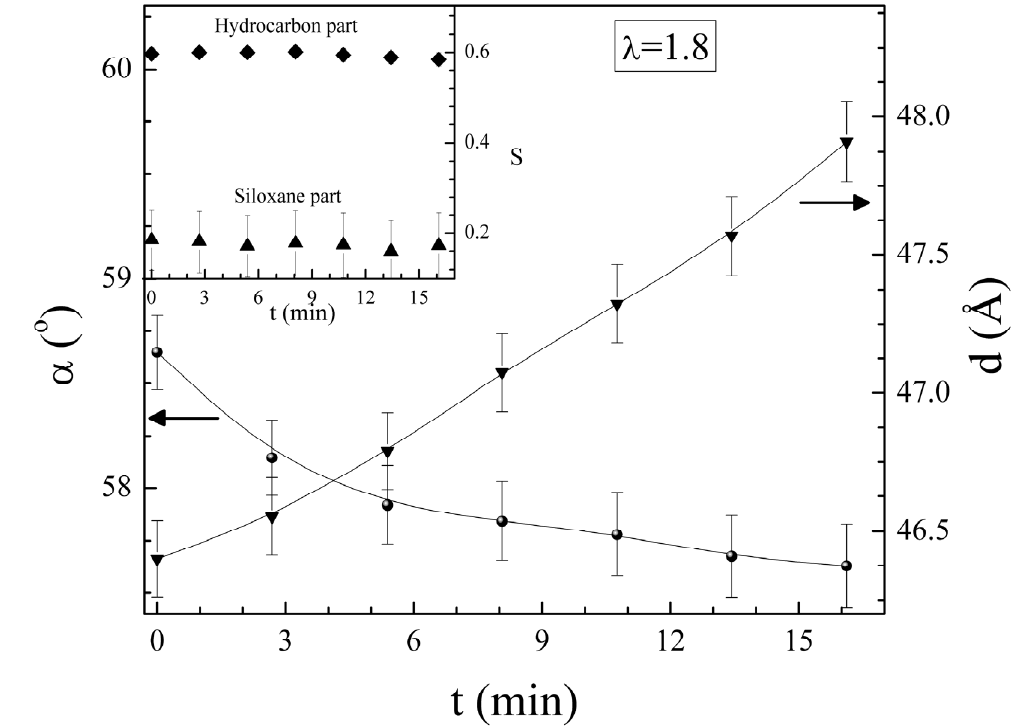
Figure 14. LCE1: Relaxation of α (left ordinate axis) and d (right ordinate axis) at a constant strain of λ = 1.8 for LCE1. The inset shows the relaxation of S for the hydrocarbon and siloxane parts of the